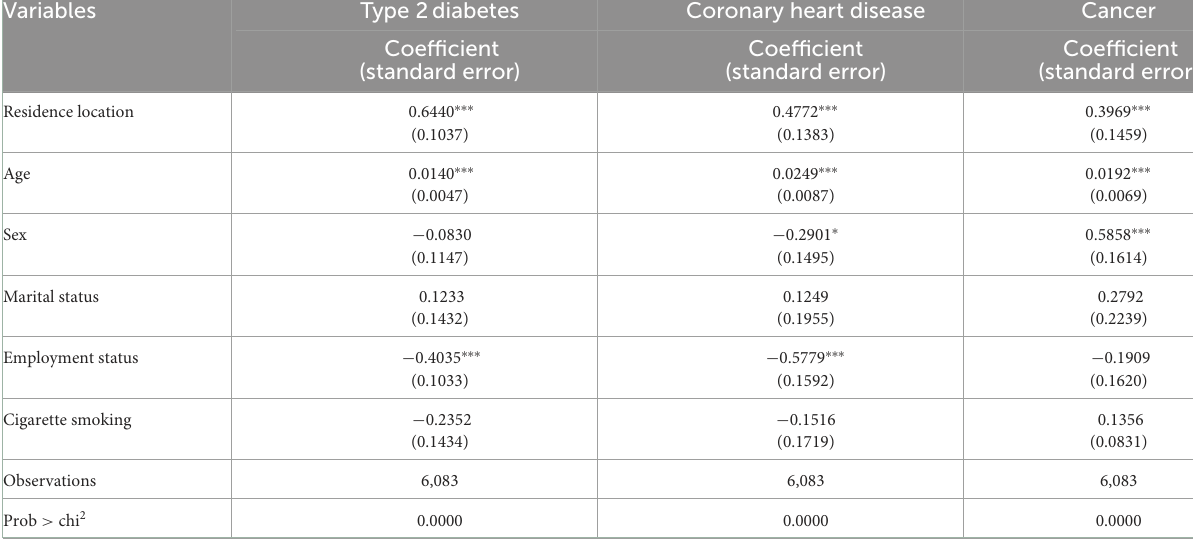
TABLE 5 Results based on the 2021 follow-up